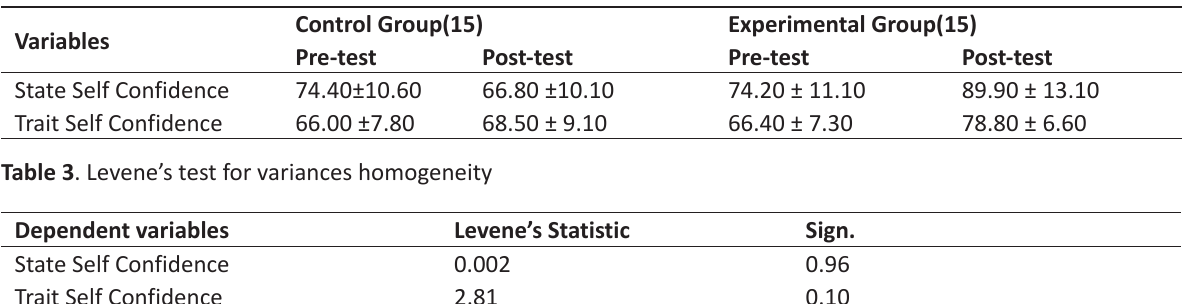
Table 2. The mean scores of state confidence in the control and experimental groups